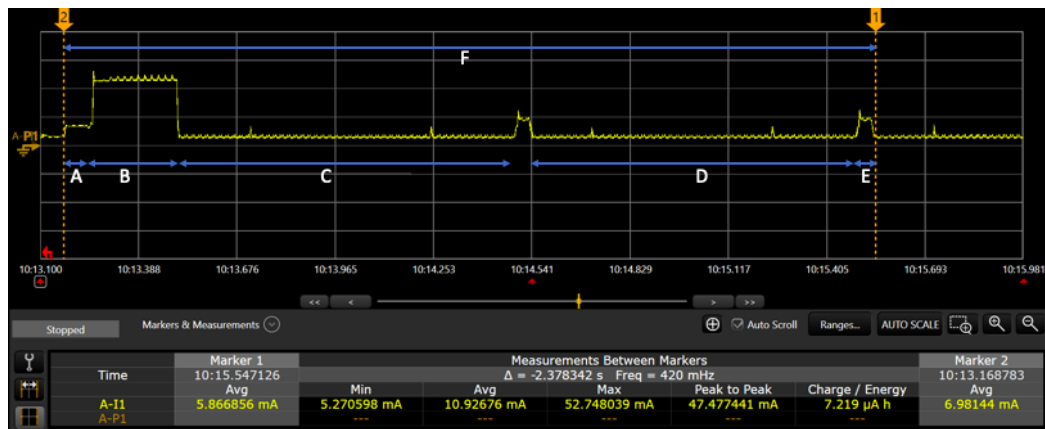
Figure 13. Power measurement of the LoRaWAN communication.